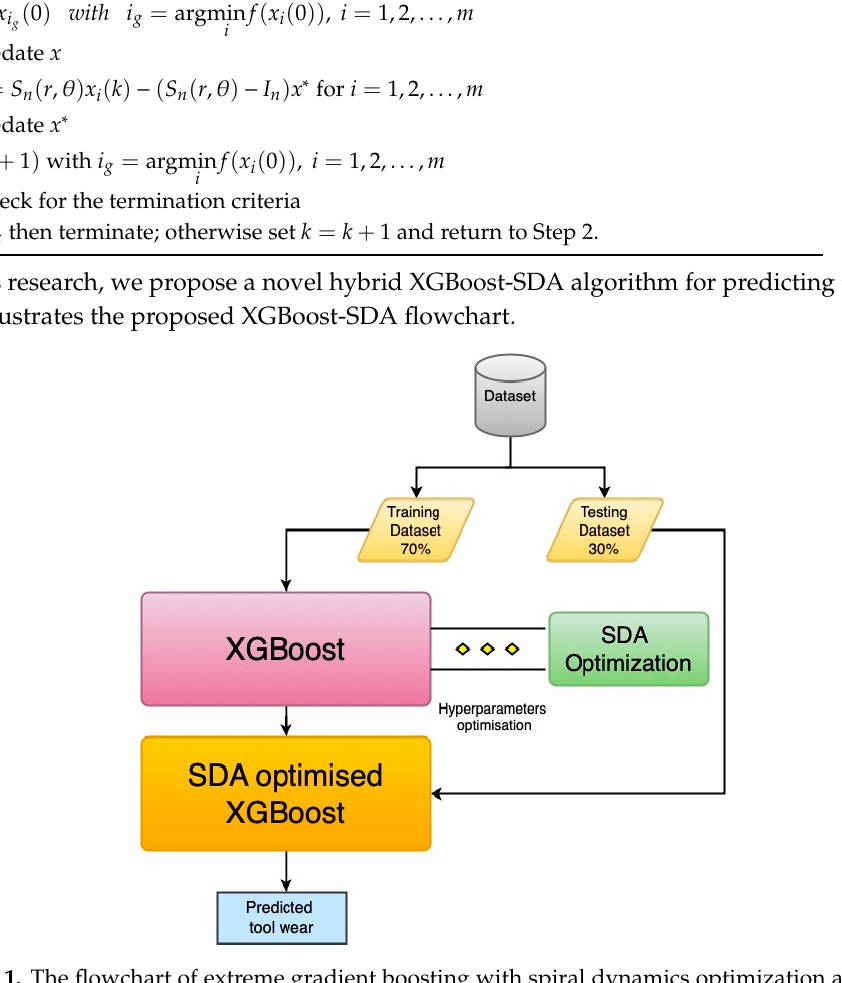
Algorithm 1: Spiral dynamics optimization algorithm